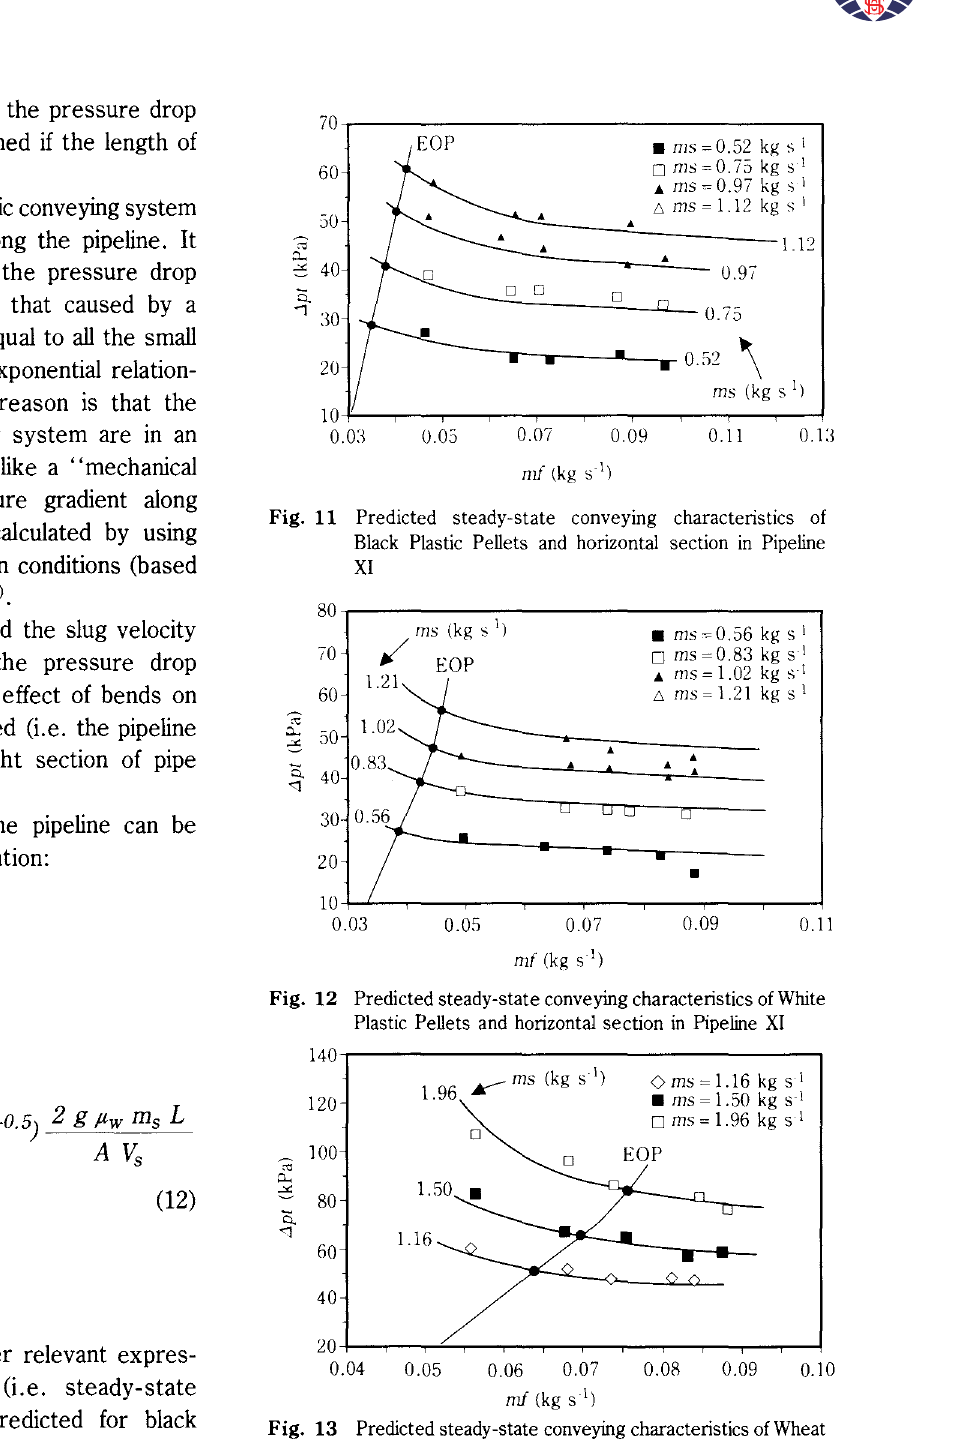
Fig. 13 Predicted steady-state conveying characteristics of Wheat and horizontal section in Pipeline